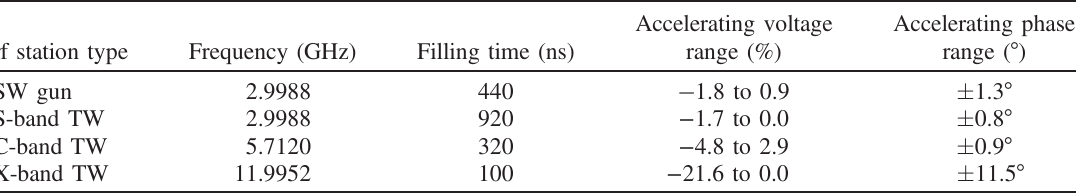
TABLE I. Second bunch tuning range.